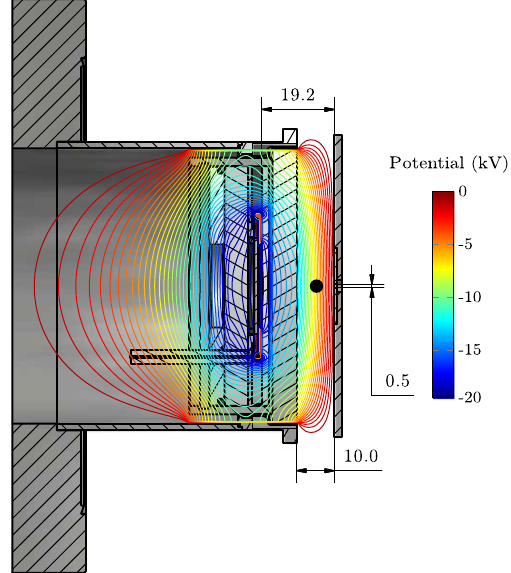
the electron beam can be controlled by the magnetic ¼ 484 mm from solenoid lens positioned at a distance d sol ¼ the gas cloud. The detector assembly is positioned d det 293 mm behind the magnetic solenoid lens. The detector assembly consists of a microchannel plate (MCP) and a phosphor screen which is imaged onto a CCD camera.